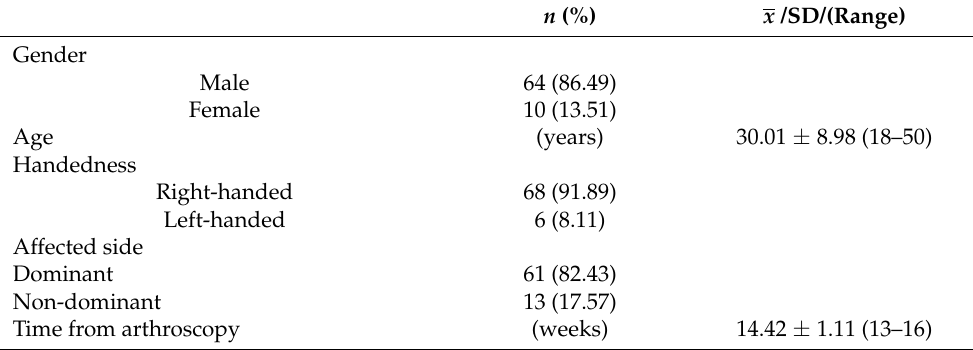
Table 1. Patient demographic and clinical characteristics ( n = 74).